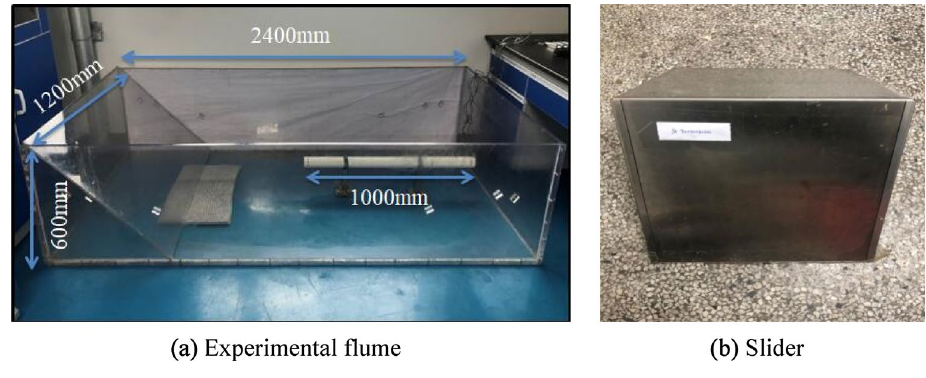
Figure 1. Flume device and slide block ( a ) experimental flume, ( b )